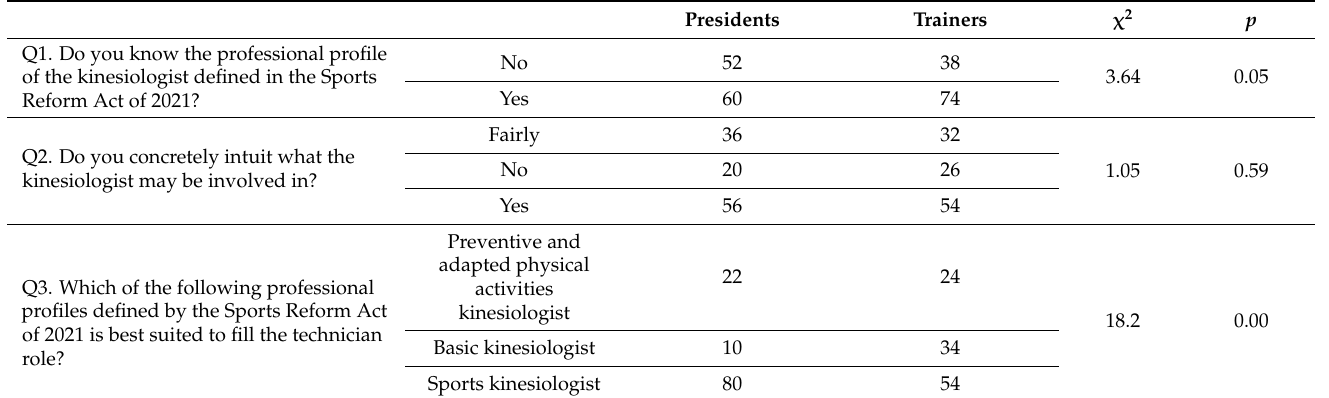
Table 4. Differences in perception between presidents and